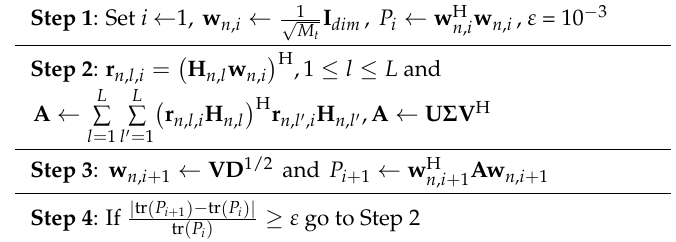
Table 2. Maximization of the SNR in spatial multiplexing transmission mode.